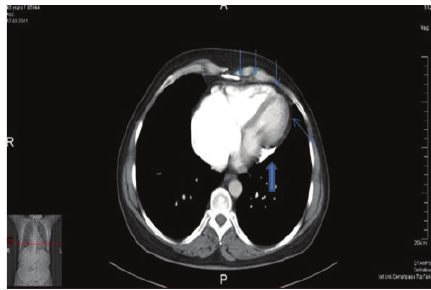
Figure 2: Pericardial thickening (thin arrows) and heavy calcifica- tion of left atrioventricular groove (thick arrow) in cardiac CT.